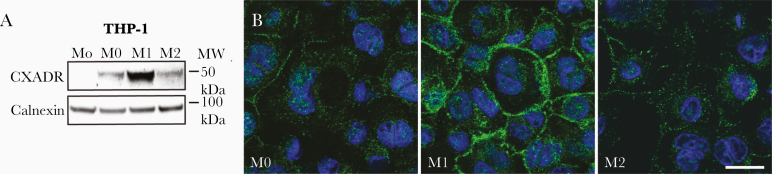
Induction of coxsackievirus and adenovirus receptor (CXADR) during monocyte-to-macrophage differentiation. A, Western blot analysis showing CXADR protein levels in THP-1 cells cultured as monocytes (Mo), differentiated into macrophages (M0), and further polarized into M1 or M2 macrophages. Abbreviation: MW, molecular weight. B, Immunofluorescence staining for CXADR (green) in THP-1 cells differentiated into M0, M1, or M2 macrophages. Cell nuclei were counterstained with DAPI (blue). Images were obtained with a Zeiss LSM700 confocal microscope and processed with NIS-Elements software (version 4.0). (https://www.microscope.healthcare.nikon.com/products/software/nis-elements). (Scale bar represents 10 μm.)